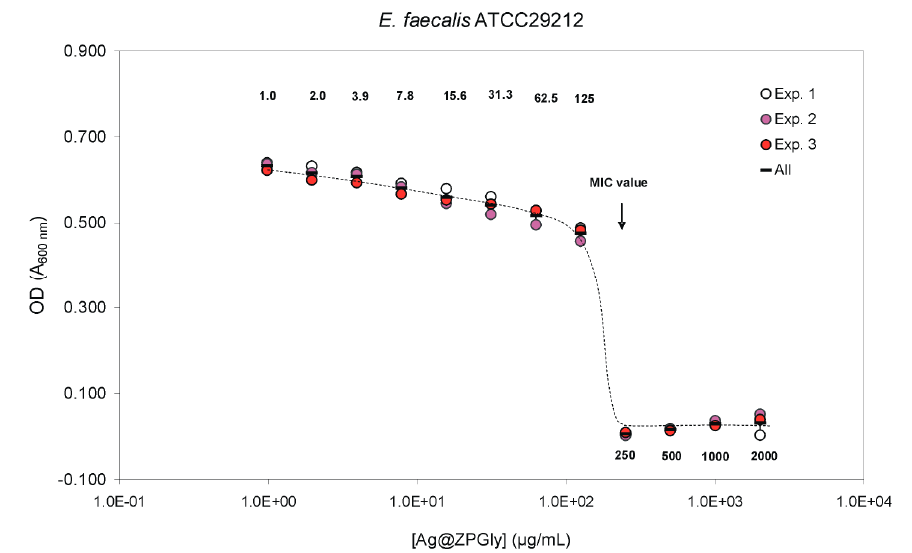
Figure 3. E. faecalis inhibition curves by Ag@ZPGly. Data reported in the plot correspond to the mean OD values found for each single experiment and the mean of the 3 experiments ± S.D.